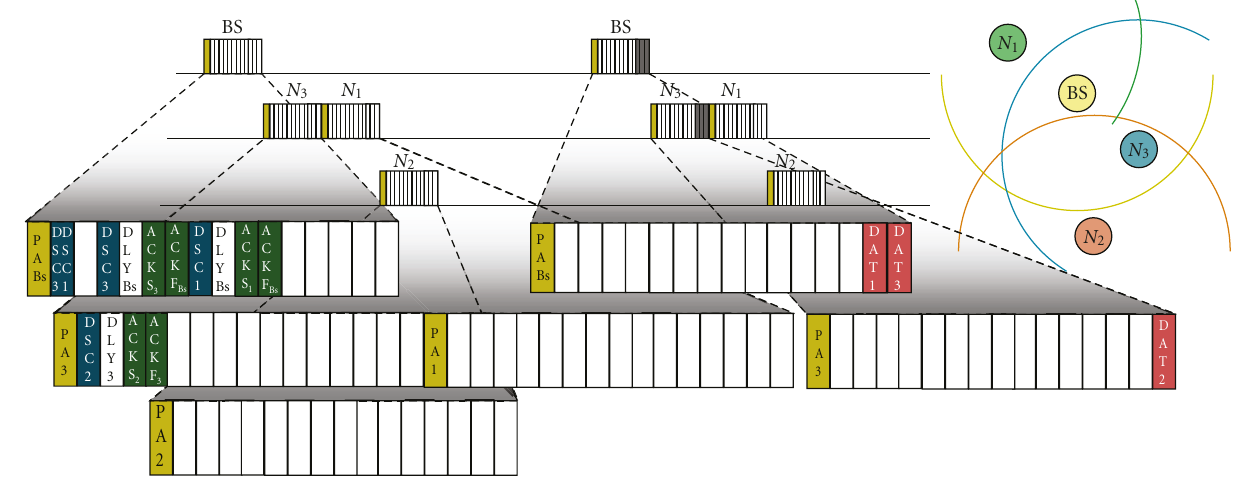
Figure 1: Example of a packet exchange in SA-MAC for the network shown in the upper right